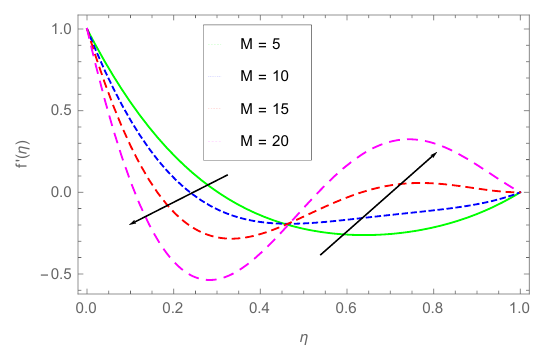
Figure 3. f (cid:48) ( η ) dependence on M . The impact of enhancing magnetic field strength through the magnetic parame- ter ( M ) on the velocity f ( η ) is displayed in Figure 4. The values of M were taken as 5.0, 10.0, 15.0, 20.0. The graph shows that at fixed M , the velocity first enhances, attains the maximum value, and then, drops with the rising values of η . The augmenting M results in a drop in the f ( η ) profile. The dropping rate enhances with the rising values of M as is clear from the increasing separation between different curves and is more drastic at the intermediate values of η . The various curves overlap at about η = 0.9. This drop in the fluid velocity is due to higher Lorentz forces, corresponding to higher values of M .